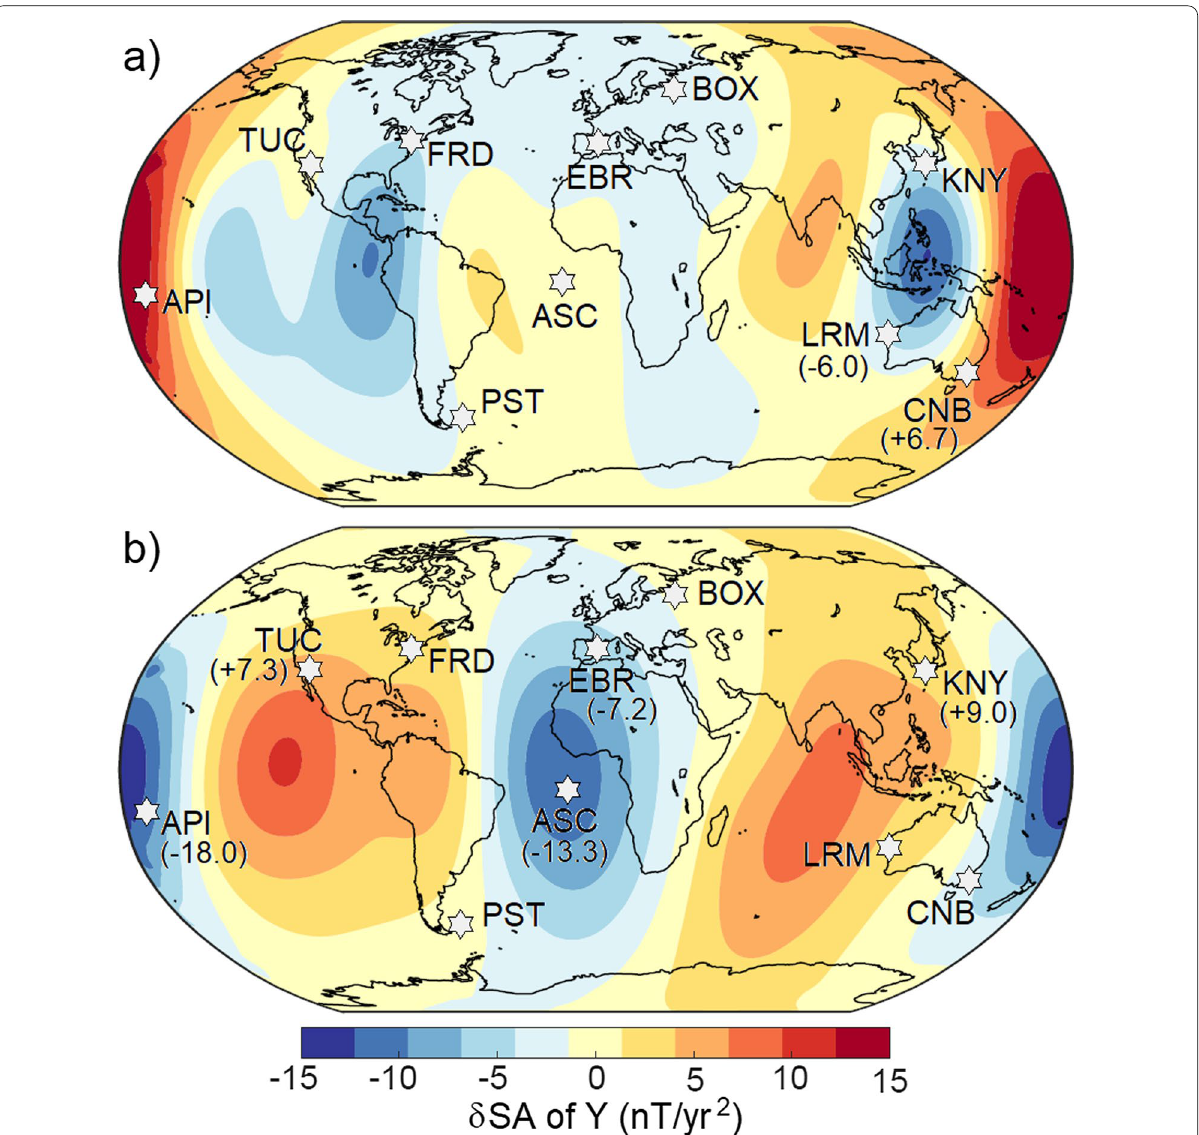
Fig. 4 Maps of the Y secular acceleration changes (δSA) on a July 1st 2017 (2017‑jerk) and b May 1st 2019 (2020‑jerk) at the Earth’s surface obtained from the CHAOS‑7.7 model. White stars in both maps indicate the location of the selected observatories. The estimated amplitude of δSA